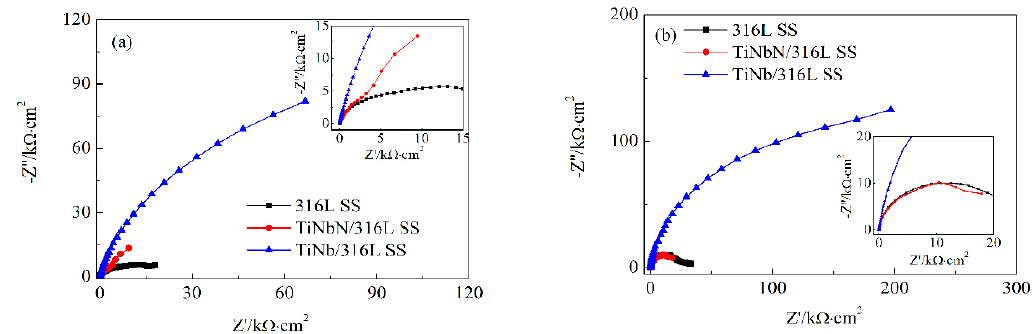
Figure 7. Nyquist impedance spectra of 316L SS, TiNb/316L SS and TiNbN/316L SS @ ( a ) open circuit potential (OCP), ( b ) 0.19 V vs mercurous sulfate electrode (MSE).